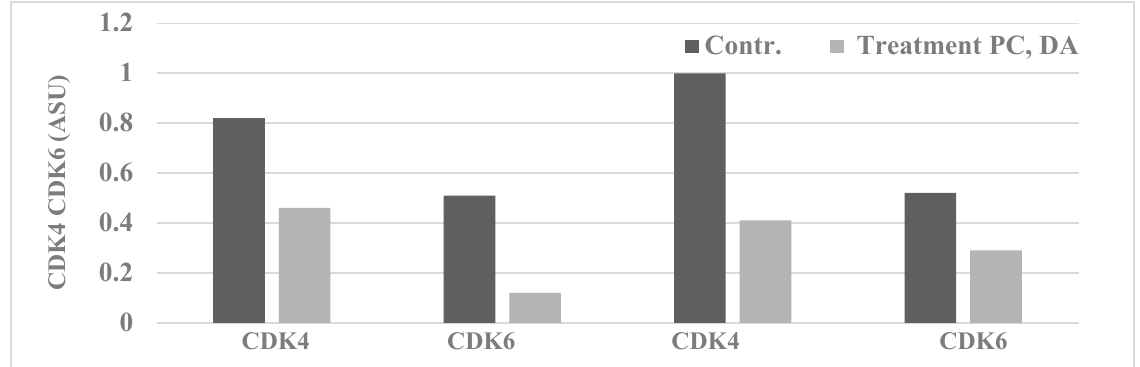
Figure 2. Effect of Chinese herbs on RB Signaling. Treatment with DA, PC and CO at their respective IC 90 doses decreased the pRB: RB ratio. Data presented as arithmetic means of ASU from duplicate determinations. pRB, phosphorylated RB; RB, retinoblastoma; ASU, arbitrary scanning unit; DA, Dipsacus asperoides ; PC, Psoralea corylifolia ; CO, Cornus officinalis . Data summarized from [14–16].